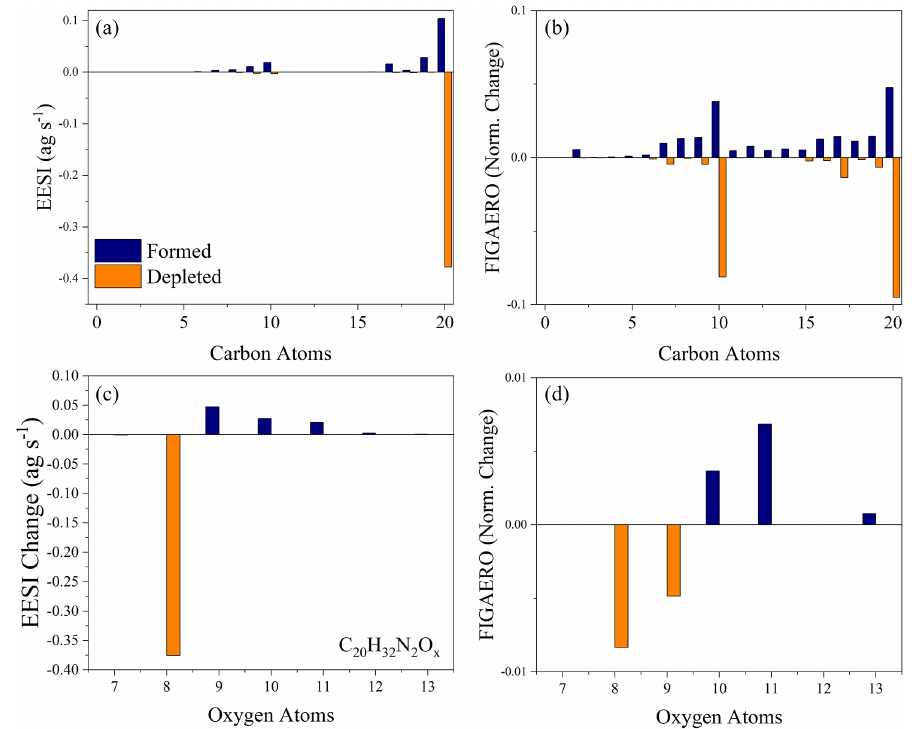
Figure 6. The carbon distribution of the molecules formed (blue) and depleted (orange) in the particle phase during aging for the EESI- ToF (a) and FIGAERO-CIMS (b) for Exp. 3. The change in the oxygen distribution for the C 20 H 32 N 2 O 8 − 13 molecules during dark aging for the EESI-ToF (c) and FIGAERO-CIMS (d) . For panels (a) and (c) , the difference is obtained by taking the difference from t = 15min and t = 150min from the EESI-ToF. Panels (b) and (d) are obtained by taking the difference in the relative sensitivity from the first and third filter. For all figures, the formation is shifted negative on the x axis relative to the nominal carbon number, and the depletion is shifted positive on the x axis comparatively.